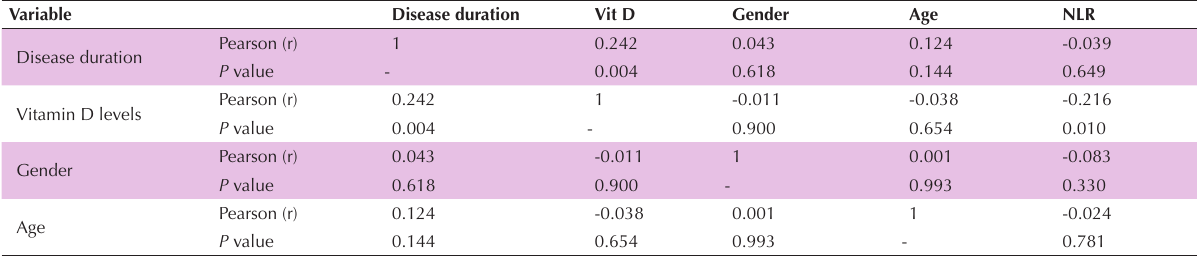
Table 3. Pearson’s correlation between NLR and other effective factors Variable Disease